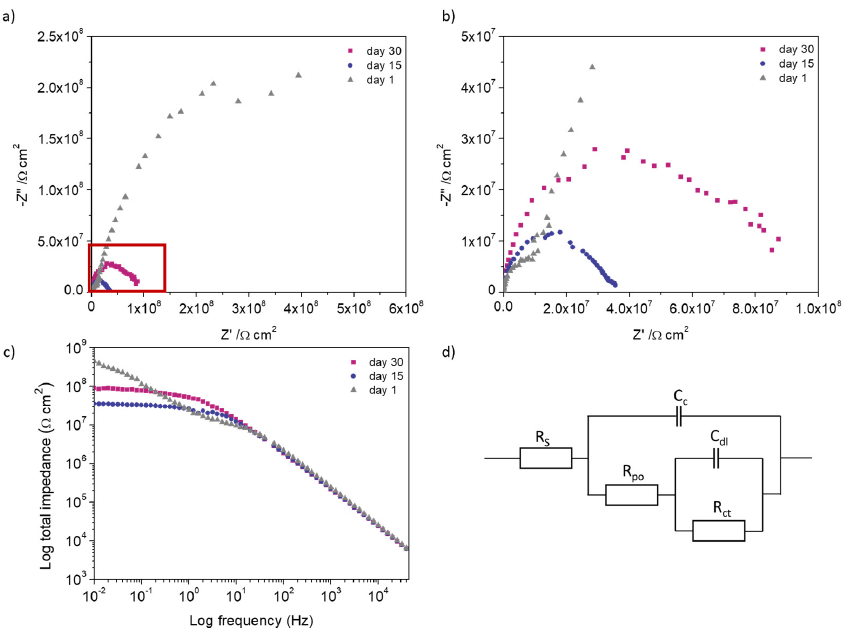
Figure 6. ( a ) Nyquist plot for selected days for PVDF base coating and ( b ) the focused area in the low frequency region for PVDF base coating. ( c )The Bode plot for days 1, 15, and 30 and ( d ) the equivalent circuit used to fit the data where R s is solution resistance, R po is pore resistance, R ct is charge transfer resistance, C c is coating capacitance and C dl is double layer capacitance.